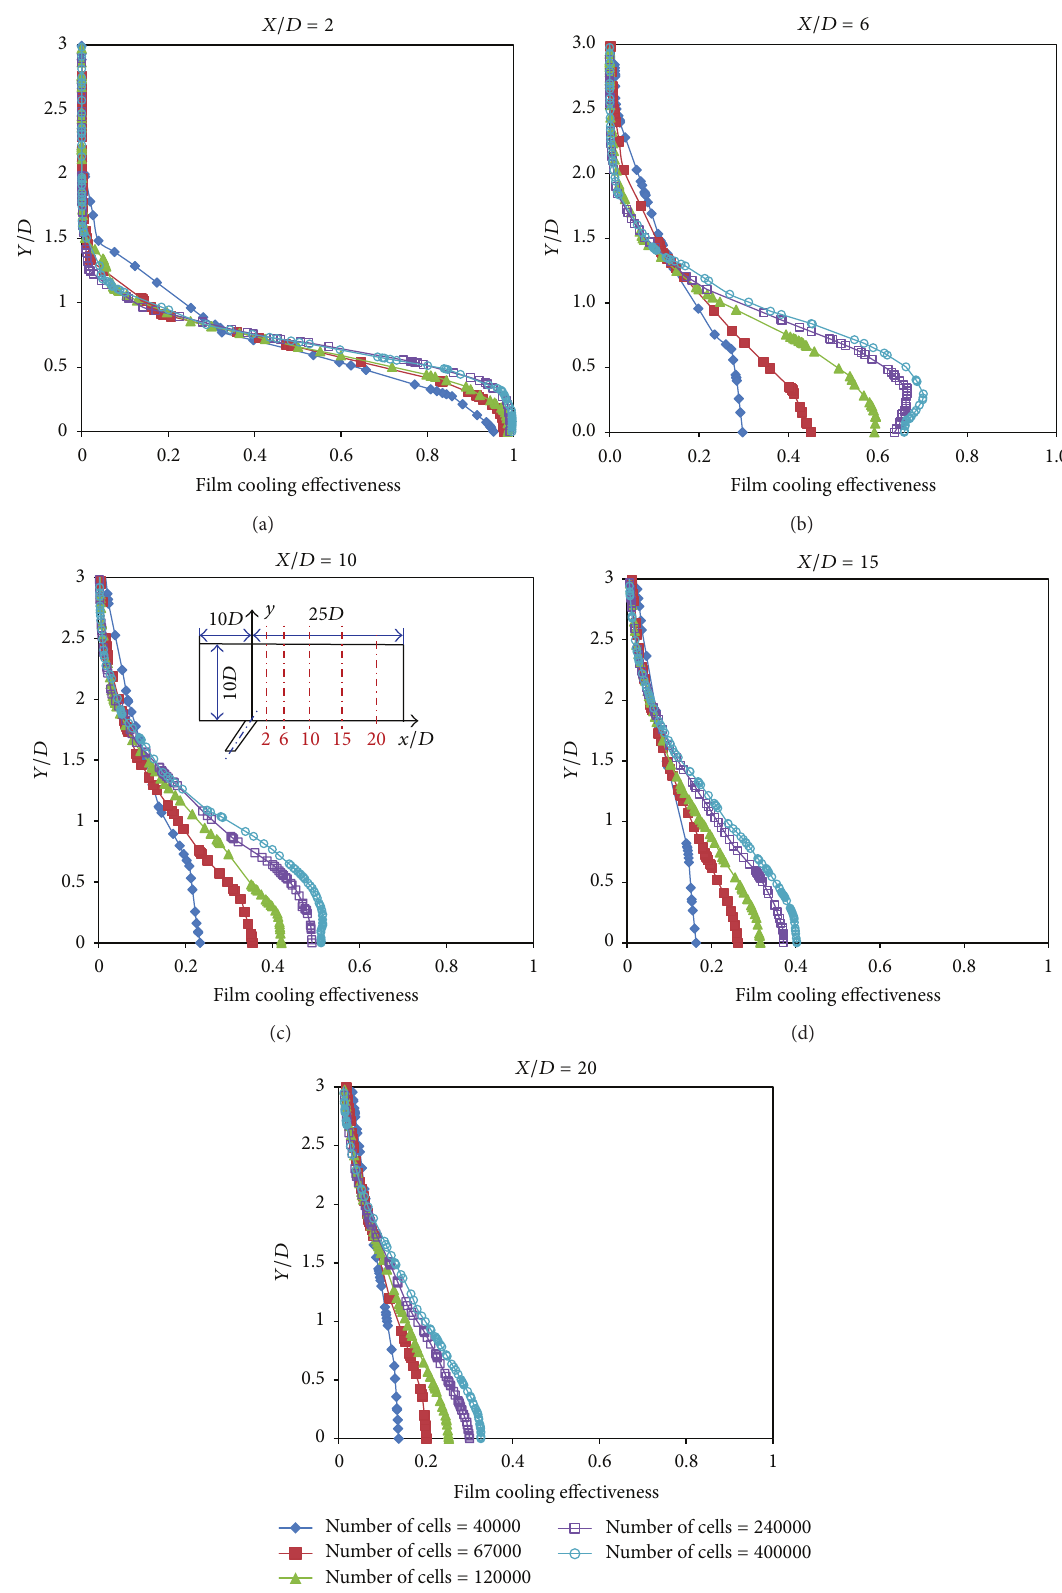
Figure 11: Variation of the wall local film cooling effectiveness with the number of